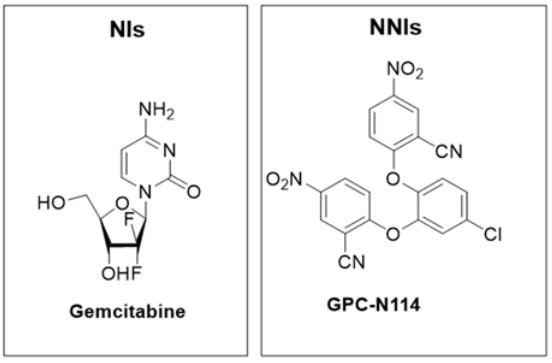
Figure 16. Chemical structures of gemcitabine and